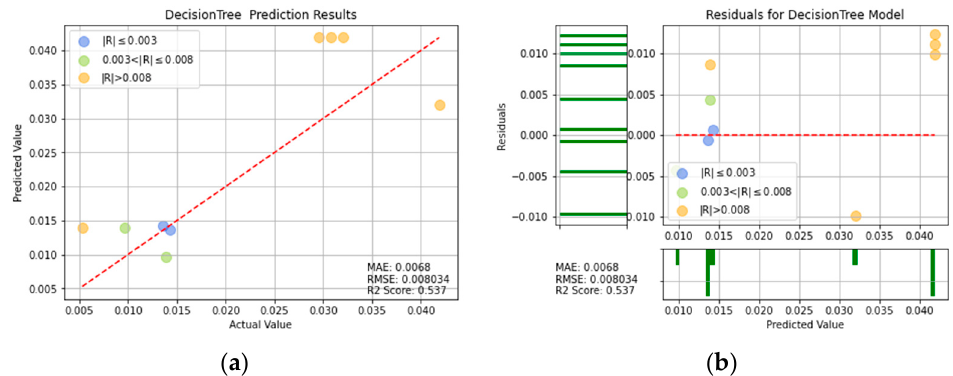
Figure 16. RF prediction results: ( a ) comparison of actual and predicted precision values, and ( b ) residual plot.